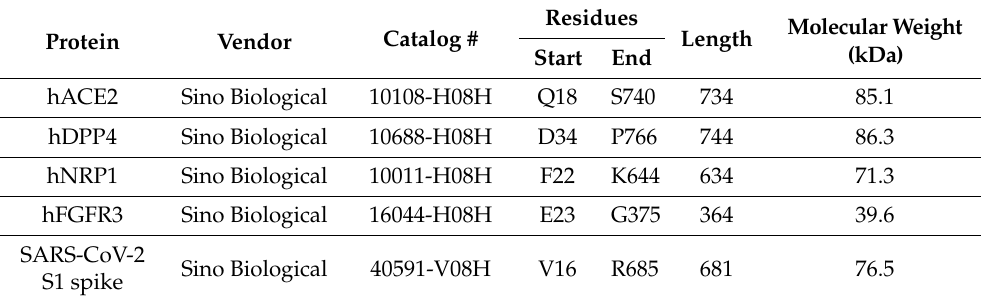
Table 1. Characteristics of recombinant human cell receptors and viral spike proteins. Protein Vendor Catalog